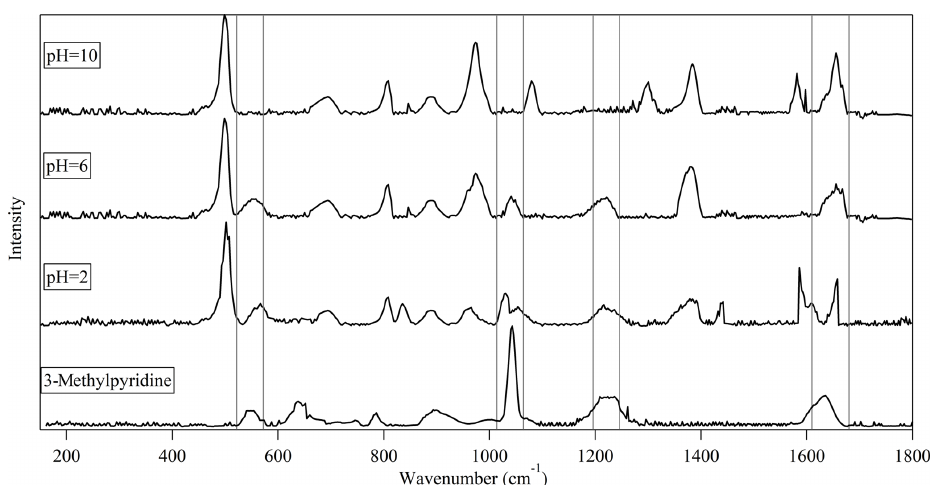
Figure 7. Surface-enhanced Raman spectra for the bulk solutions with different pH values after a bulk aqueous-phase reaction of acrolein with ammonium ion. The bottom panel shows a reference Raman spectrum of 3-methylpyridine.